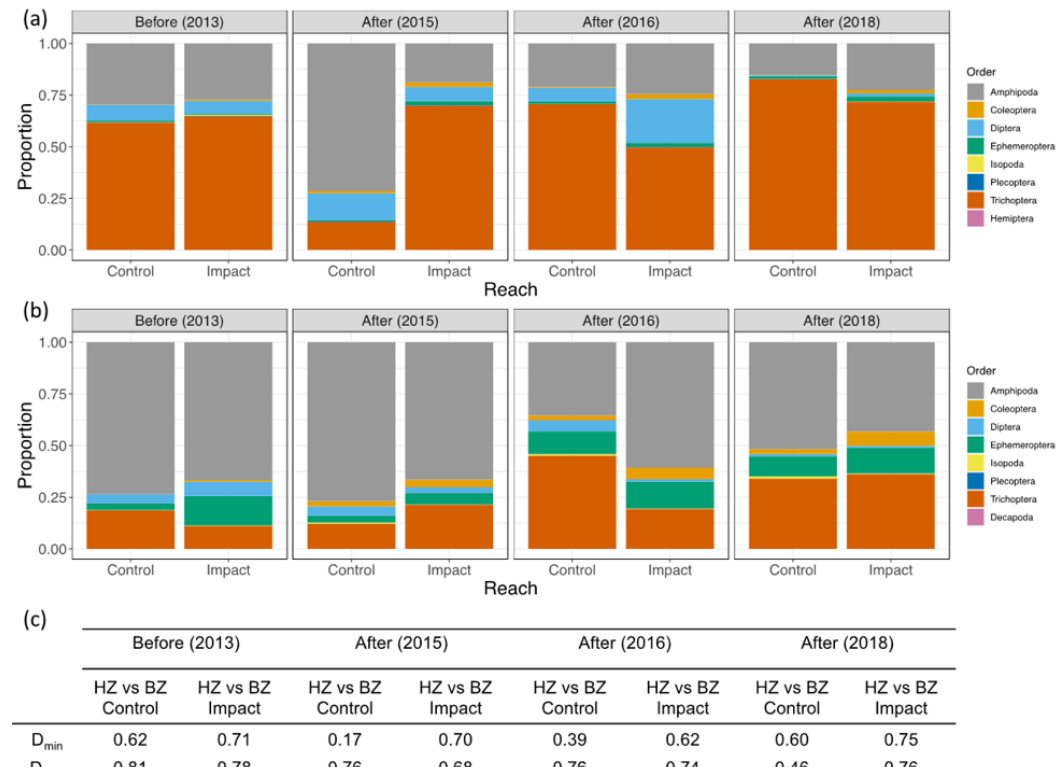
Figure 5. Relative abundance of hyporheic ( a ) and benthic ( b ) invertebrate orders in the control and impact (restored) reach pre and post restoration. To aid visualization of the data, only the two dominant classes, Insecta and Malacostraca, are shown. Beta-diversity (CNESSa dissimilarity) values between compartments ( c ) for minimum (D min ) and maximum samples sizes D max ); values can range between 0 (samples are the same) and 1 (samples are 100% different).